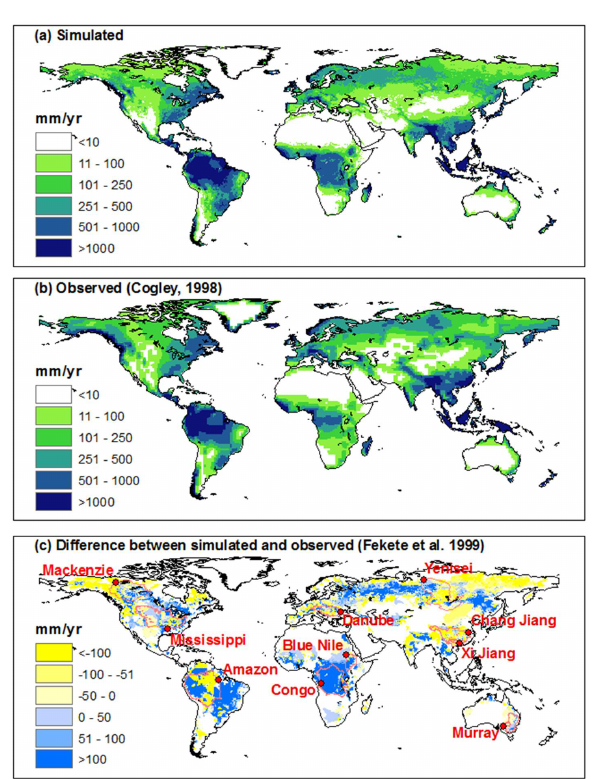
Fig. 9. Long-term mean annual surface runoff (mm): (a) LH- simulated runoff for the period 1961–1990, (b) observed runoff (Cogley, 1998) for different time periods, (c) difference between LH-simulated and Fekete et al. (1999) runoff data. The 10 large river watersheds in (c) were derived from HydroSHEDS data (Lehner et al., 2006). The geographic location of each gage station was based on Global River Discharge Database (RivDis2.0), avail- able from http://www.sage.wisc.edu/riverdata/. For comparison, we regridded 1-degree Cogley runoff data onto simulated 0.5-degree grids using the nearest neighbor